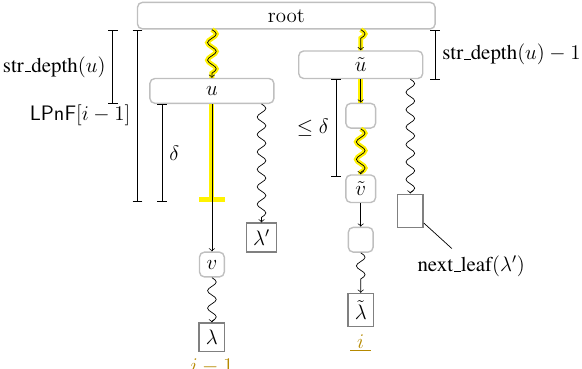
Figure 5. Computing LPnF [ i ] from LPnF [ i 1 ] by simulating a suffix link from u to ˜ u (cf. Section 3.5). − Straight arcs symbolize edges, while curly arcs symbolize paths visiting multiple nodes (which are not visualized). We have str_depth ( u ) + δ = LPnF [ i 1 ] , and hence str_depth ( ˜ u ) + δ = LPnF [ i 1 ] 1. − − − We have δ > 0 if and only if the factor starting at text position i 1 is of Type 3. In that case, we − LPnF [ i additionally walk down from ˜ u towards ˜ λ to find the lowest node ˜ v with str_depth ( ˜ v ) ≤ − 1 ] 1 = str_depth ( u ) + δ 1. While u and v are directly connected with an edge, the path from ˜ u to ˜ v − − may contain multiple